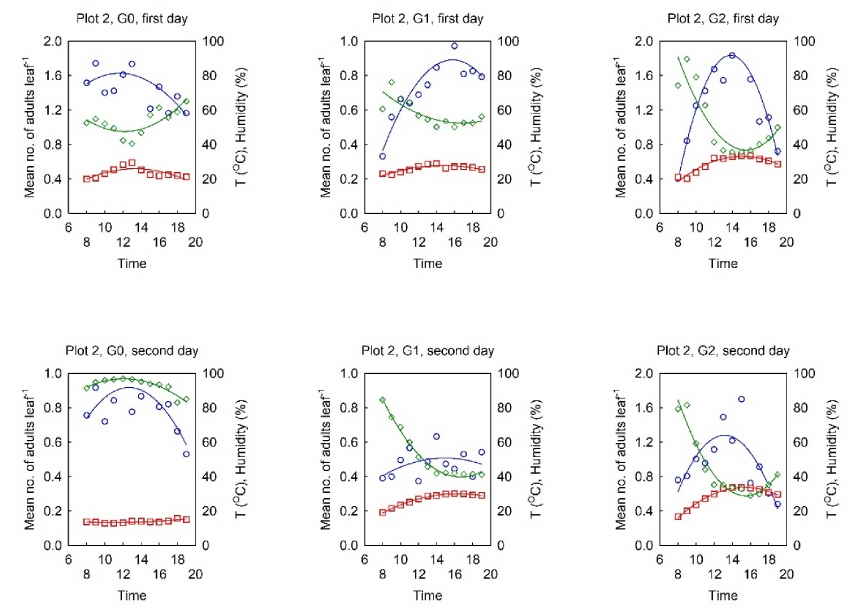
Figure 4. Dynamics of the diurnal activity of the OLB population in Plot 2 (Incinta): G0 = win- tered population; G1 = first generation; G2 = second generation; blue = number of adults in flight; green = relative air humidity; red = air